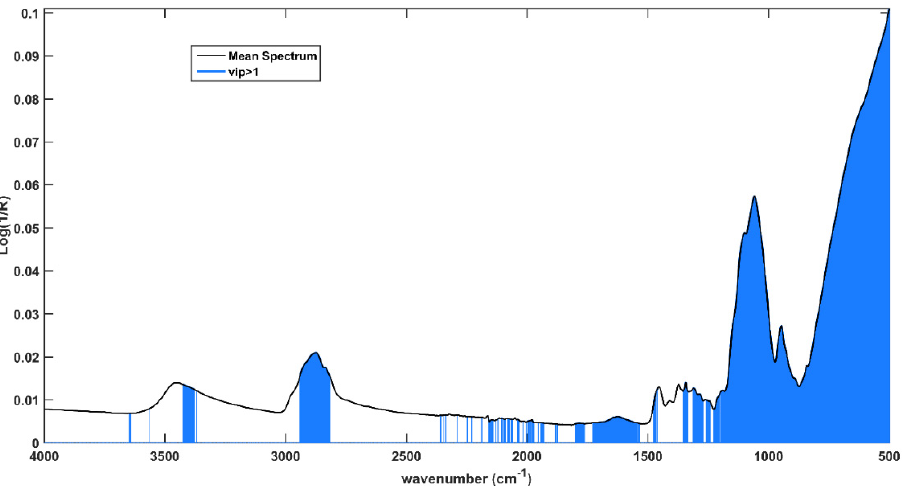
Figure 4. Average spectrum collected on the intact tablets. Spectral variables presenting VIP > 1 are highlighted in light blue.